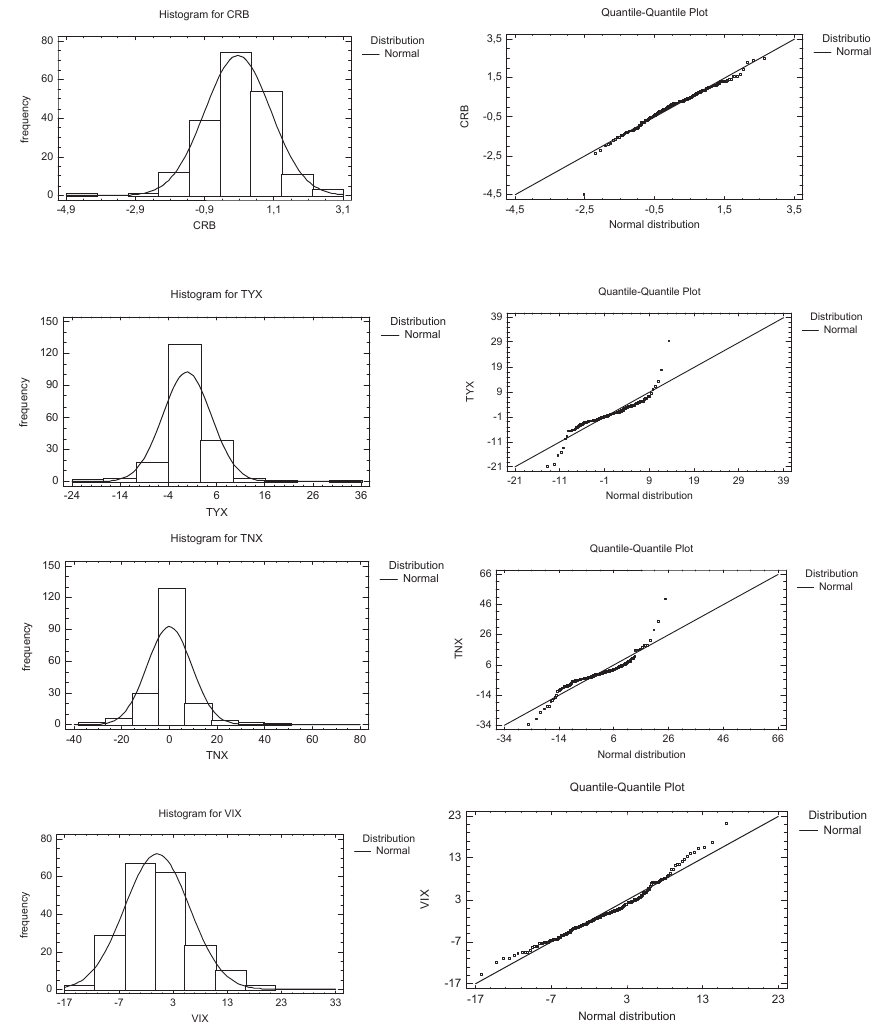
Fig. 4 – Histograms and Q-Q plots of the 1) Thomson Reuters/Jefferies CRB index (TR/J CRB); 2) 30-Year treasury yield index (TYX); 3) 10-Year treasury yield (TNX); and 4) Implied volatility of S&P 500 index (VIX); over the period 1999-2015/04. Source: Own calculations in Statgraphics Centurion